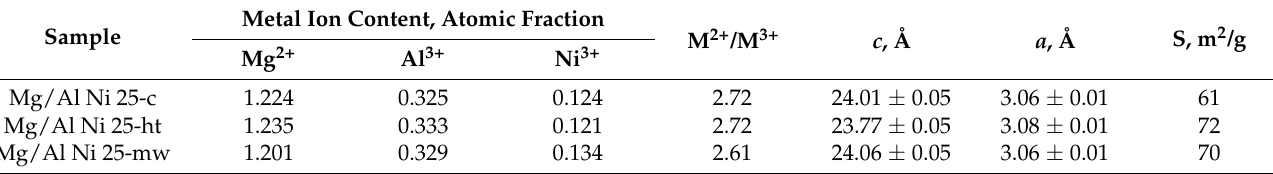
Table 1. Elemental composition, crystal lattice parameters and textural characteristics of LDHs synthesized by different methods. Sample